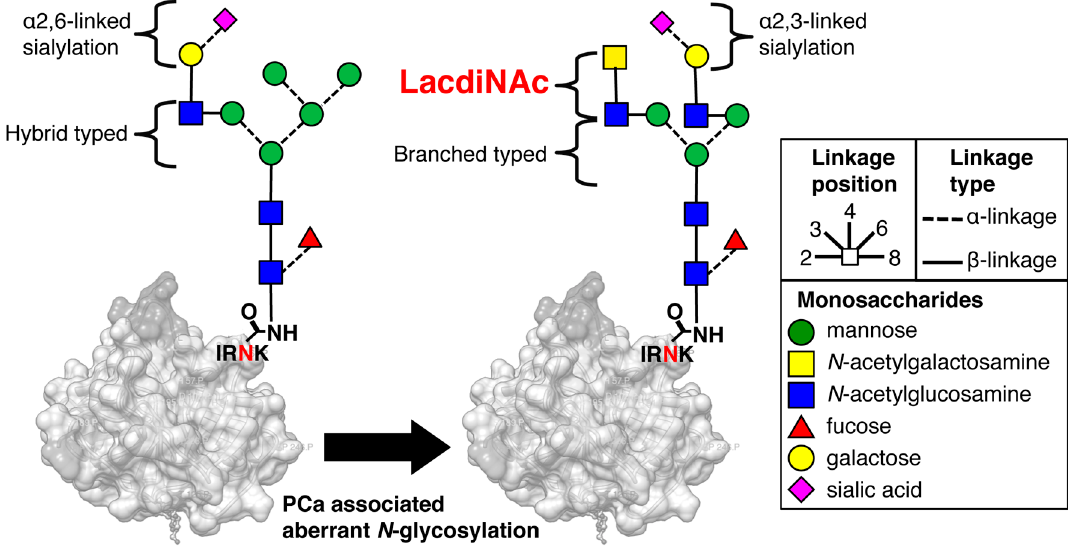
Figure 1. Prostate cancer (PCa)-associated aberrant N -glycosylation of prostate-specific antigen (PSA). PSA derived from PCa serum and culture supernatant of LNCaP carries Wisteria floribunda agglutinin (WFA)-reactive LacdiNAc glycans; this is not the case for PSA derived from benign prostatic hyperplasia (BPH) serum. PCa-associated aberrant LacdiNAc carrying PSA glycosylation isomer designated as PSA–glycosylation isomer (PSA-Gi) [21]. Carbon linkage positions are denoted by the bond position drawn on each monosachharide. IRNK indicate N -glycosylation site of